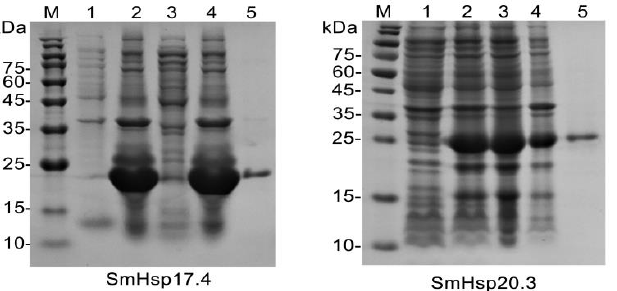
Figure 8. Expression and purification of recombinant SmHsp proteins by SDS-PAGE. M, molecular weight marker; lanes 1 and 2, un-induced and induced E. coli with pET28a (+)/SmHsps, respectively; lanes 3 and 4, supernatant and inclusion body of pET28a(+)/SmHsps after IPTG induction, respectively; lane 5, Ni-NTA affinity-purified pET28a (+)/SmHsp proteins.